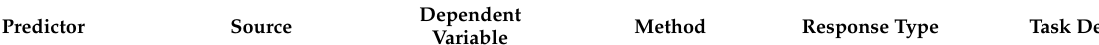
Table 1. Details of the study